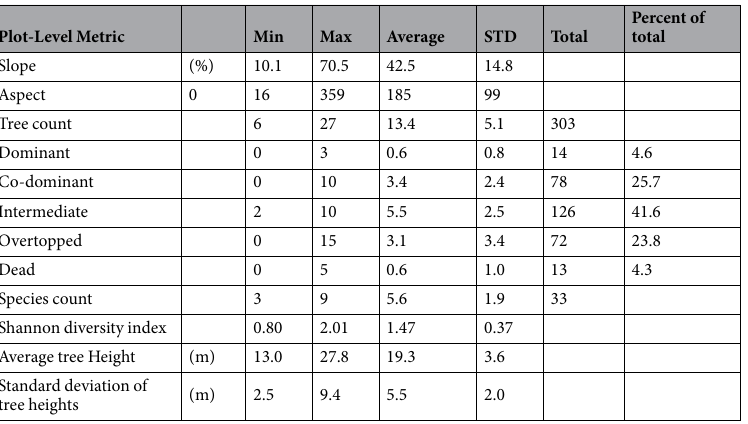
Table 2. Summary of plot level data collected from the 23 plots in Robinson Forest used for evaluating tree segmentation